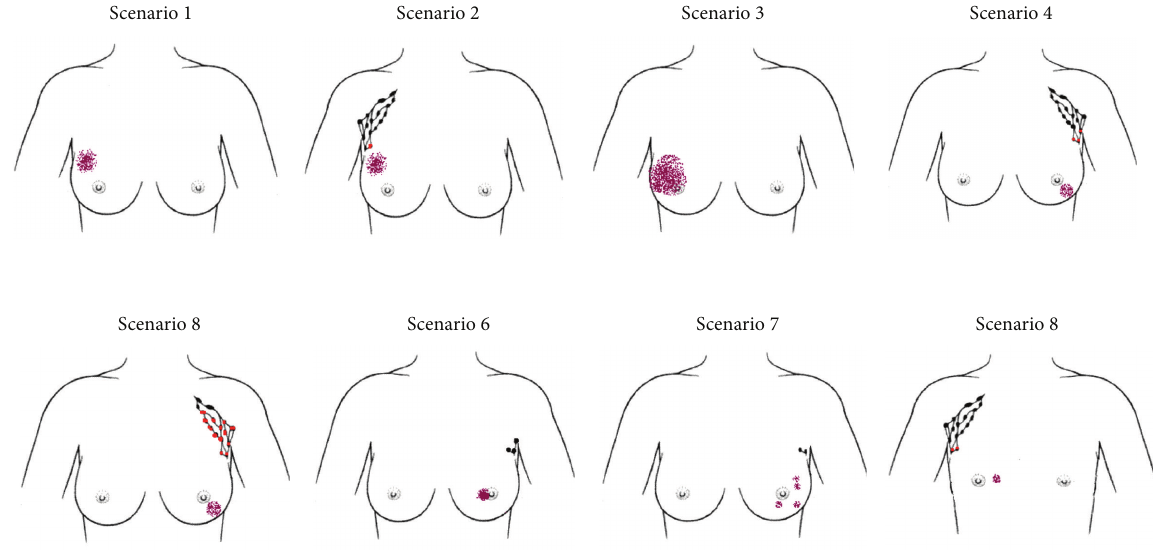
Figure 4: Illustrations for patient